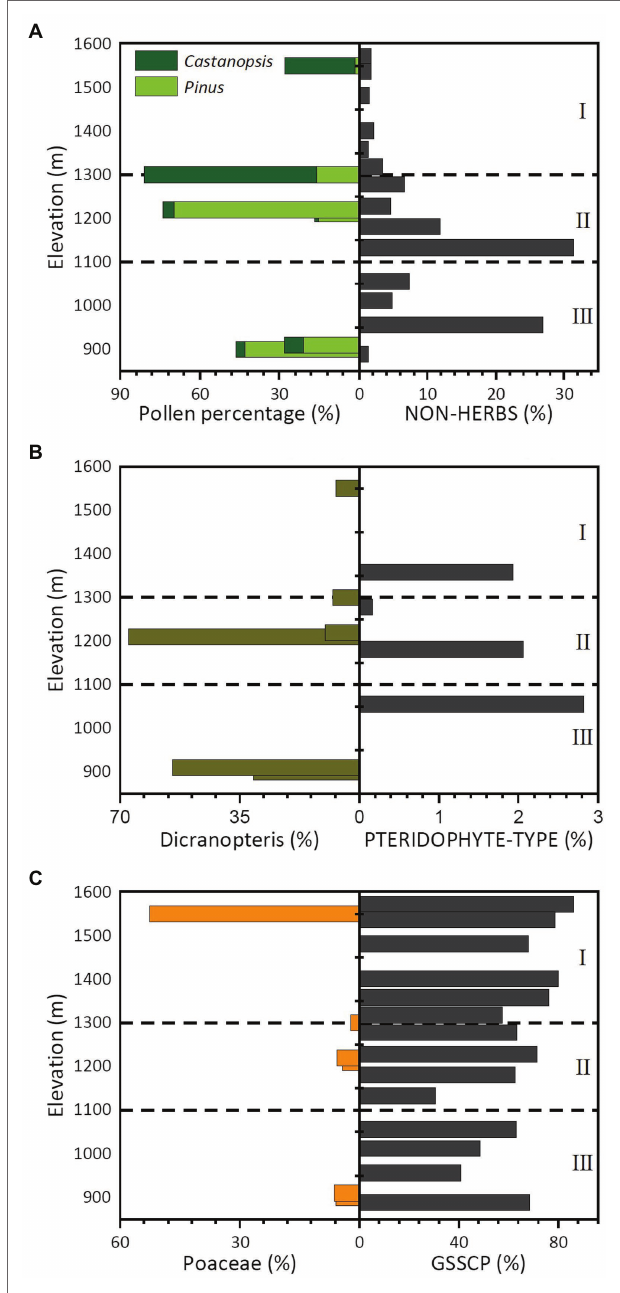
FIGURE 7 | Bar chart showing the selected pollen (Qiu, 1993) and phytolith assemblages along the sampled elevation gradient in the Daiyun Mountains. (A) Major arboreal pollen versus Non-herb phytoliths; (B) Dicranopteris versus Pteridophyte phytoliths; (C) Poaceae pollen versus